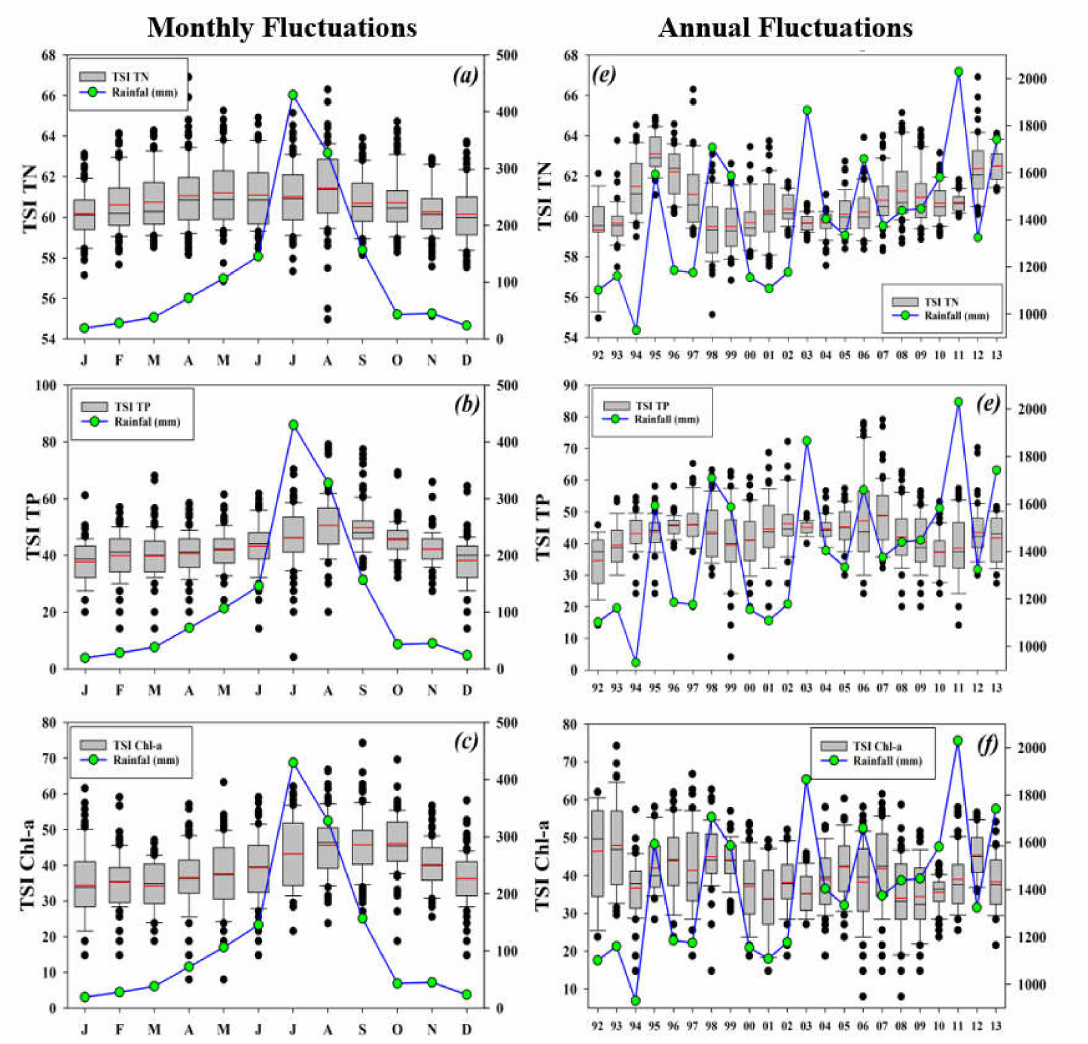
Figure 8. Seasonal ( a – c ) and interannual ( d – f ) fluctuations in the trophic state index dynamics in the Soyang reservoir. The right-hand y-axis indicates rainfall intensity